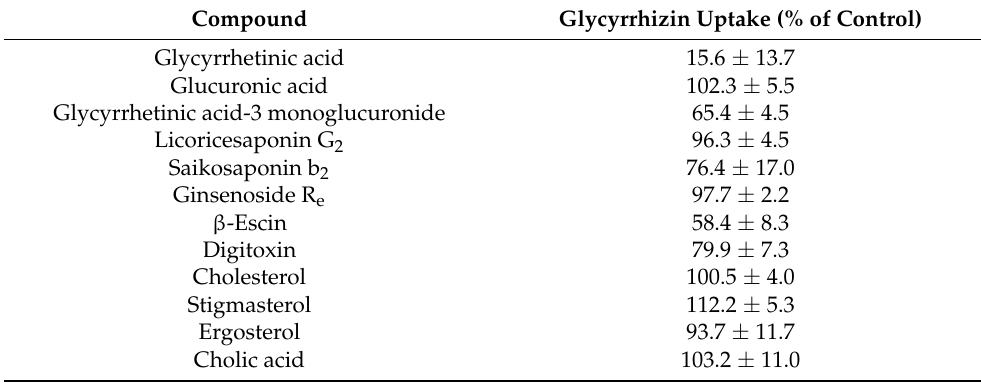
Table 2. Effects of various compounds on ATP-dependent GL uptake. Tonoplast vesicles were incubated with 100 µ M GL, and 5 mM MgATP in the absence (control) or presence of 100 µ M of the compounds indicated. Values are presented as the mean ± standard deviation from triplicate